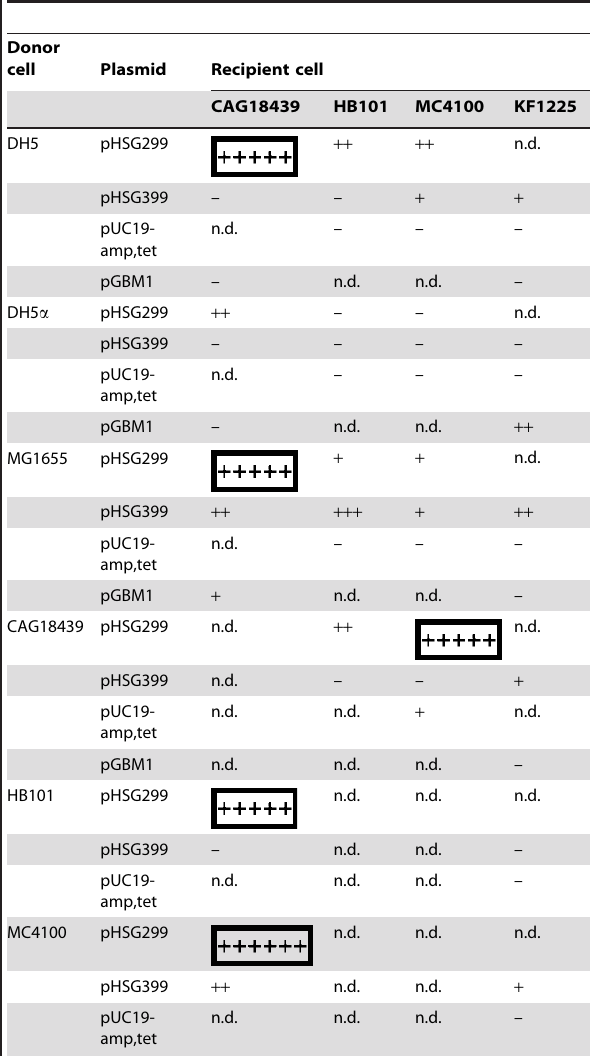
Table 2. Lateral plasmid transfer with various combinations of strains and plasmids in colony biofilm culture.